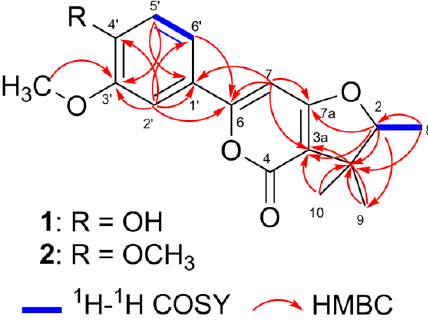
Figure 2. Key HMBC and 1 H- 1 H COSY correlations of compounds 1 and 2 .